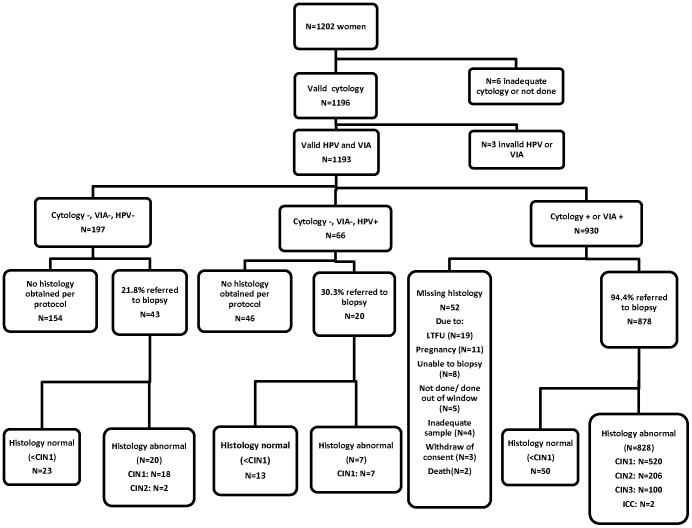
Study Flow Chart.